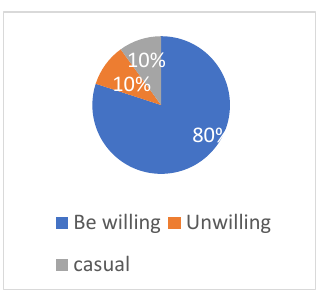
Figure 15. Analysis of willingness to use interactive technology .